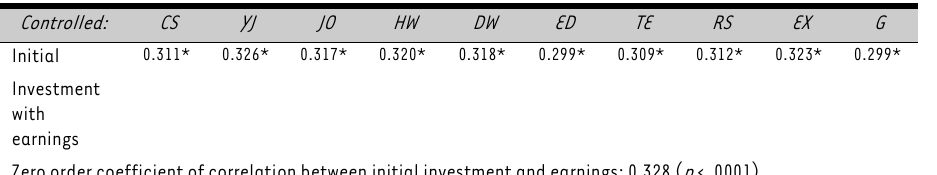
TABLE 4: Partial correlations between initial investment and earnings with variables controlled